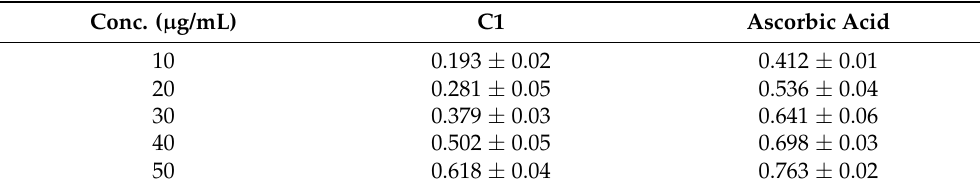
Table 7. Reduction capability activity of C1.